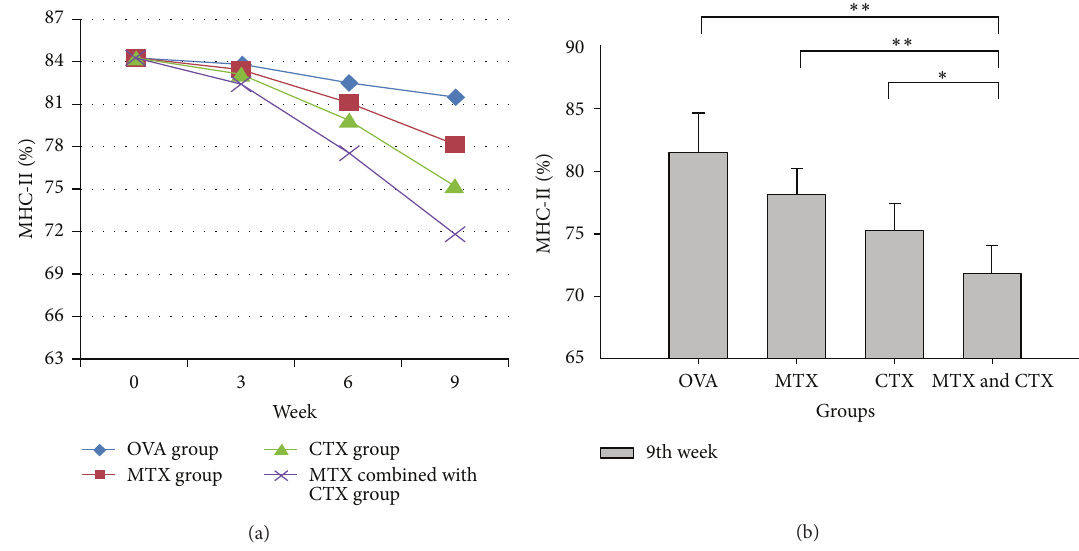
Figure 4: (a) Dynamic changes of MHC-II expression in each group. (b) Comparison of MHC-IIexpression in each group on 9th week. Data represented one of at least three independent experiments with 5 mice per group ( ∗ 𝑃 < 0.05 , ∗∗ 𝑃 < 0.01 ).